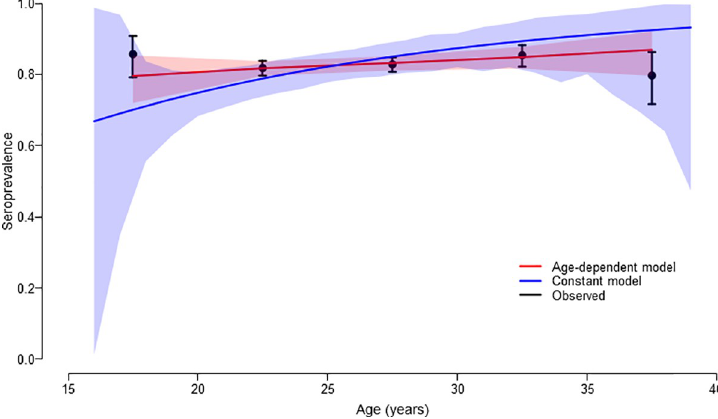
Fig 2. Observed and model-predicted seroprevalence of rubella by age (Data presented with 95% CIs). Base layer of the map can be found at